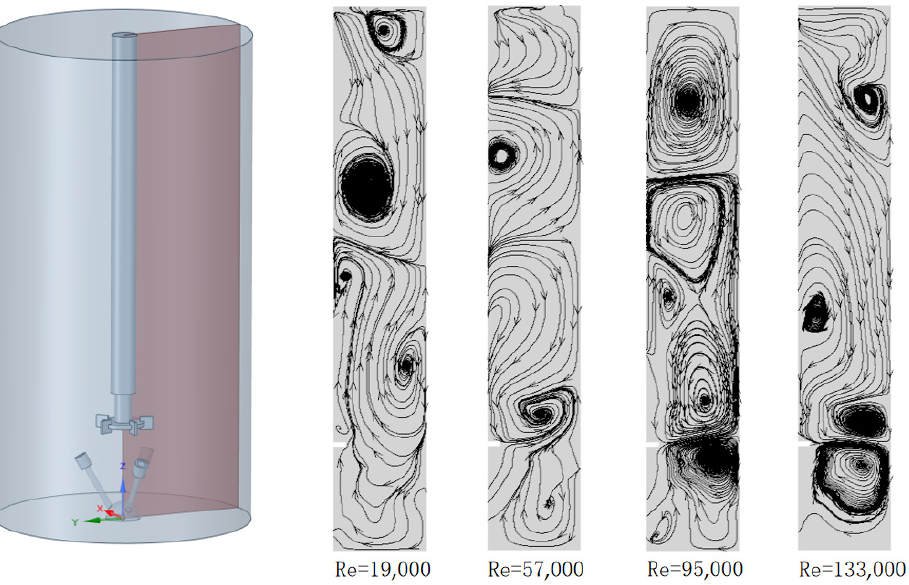
Figure 12. Annulus flow diagram of stirred tank Taylor reactor.